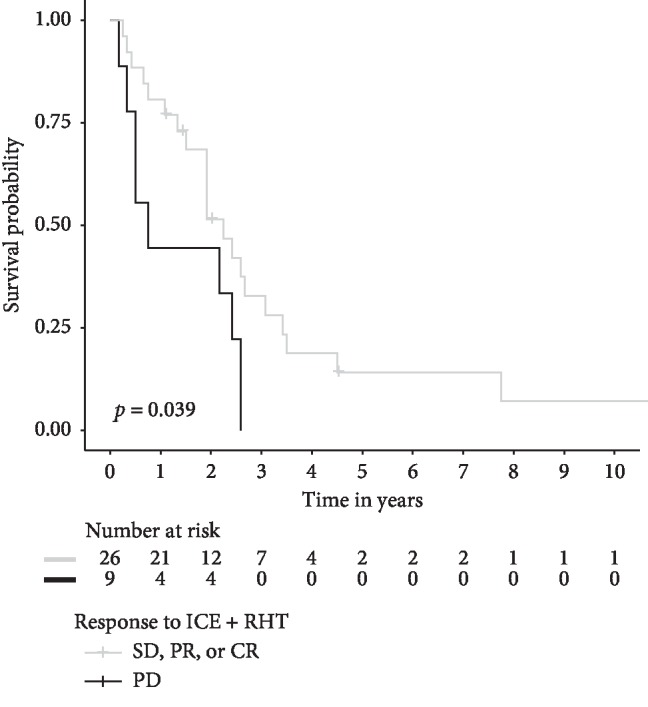
Kaplan–Meier estimates of overall survival for LA-STS patients with disease stabilization or response (SD/PR/CR, n = 26) and progressive disease (PD, n = 9) as the best radiographic response to ICE + RHT. CR, complete response; SD, stable disease; PD, progressive disease; and PR, partial remission. The p value was assessed by the log-rank test.